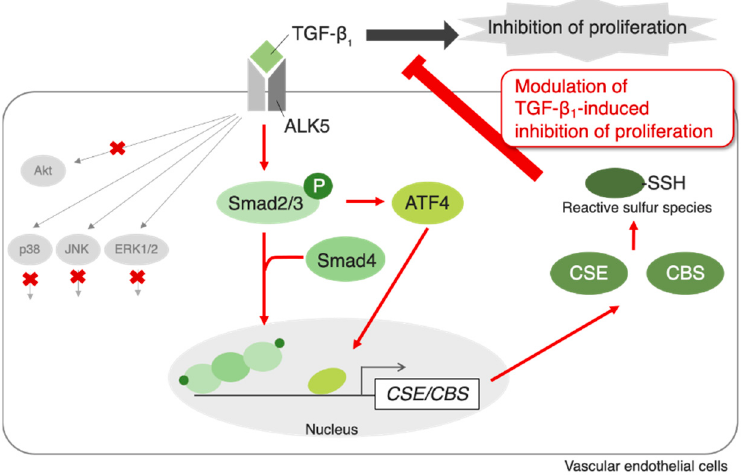
Figure 9. Summary of the present study. TGF- β 1 activates the ALK5-Smad2/3/4 and ALK5-Smad2/3- ATF4 pathways to induce CSE and CBS, reactive sulfur species-producing enzymes in vascular endothelial cells. The Akt, p38 MAPK, JNK, and ERK1/2 pathways are not involved in this induction. As a result, RSS, particularly high-molecular-mass RSS, are increased. The increased RSS may modulate the regulation by TGF- β 1 of vascular endothelial cell functions such as inhibition of the proliferation in the repair process of damaged